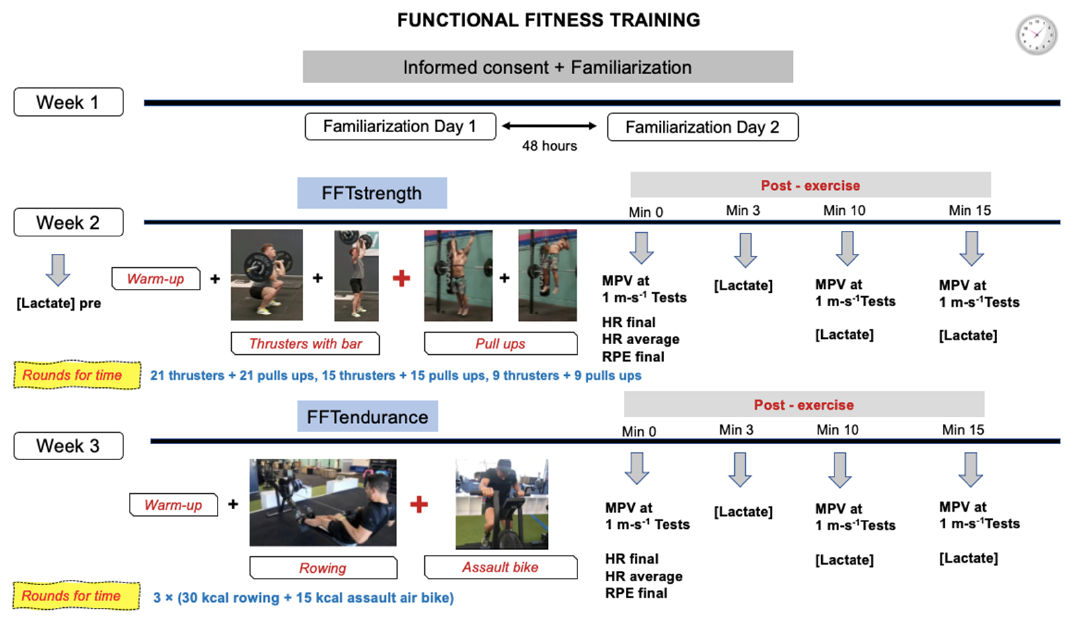
Figure 2. FFT = functional fitness training; MPV = Mean propulsive velocity; Min = minutes; HR = Heart rate; RPE = Rate of perceived exertion.